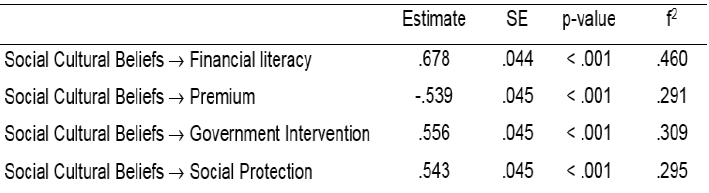
Table 13 reveals that social cultural beliefs (  =0.678, p< .001, f 2 =0.460) has a significant effect on the perception of the respondents in terms of financial literacy. This indicates that social cultural beliefs positively affect the perception of the respondents in terms of financial